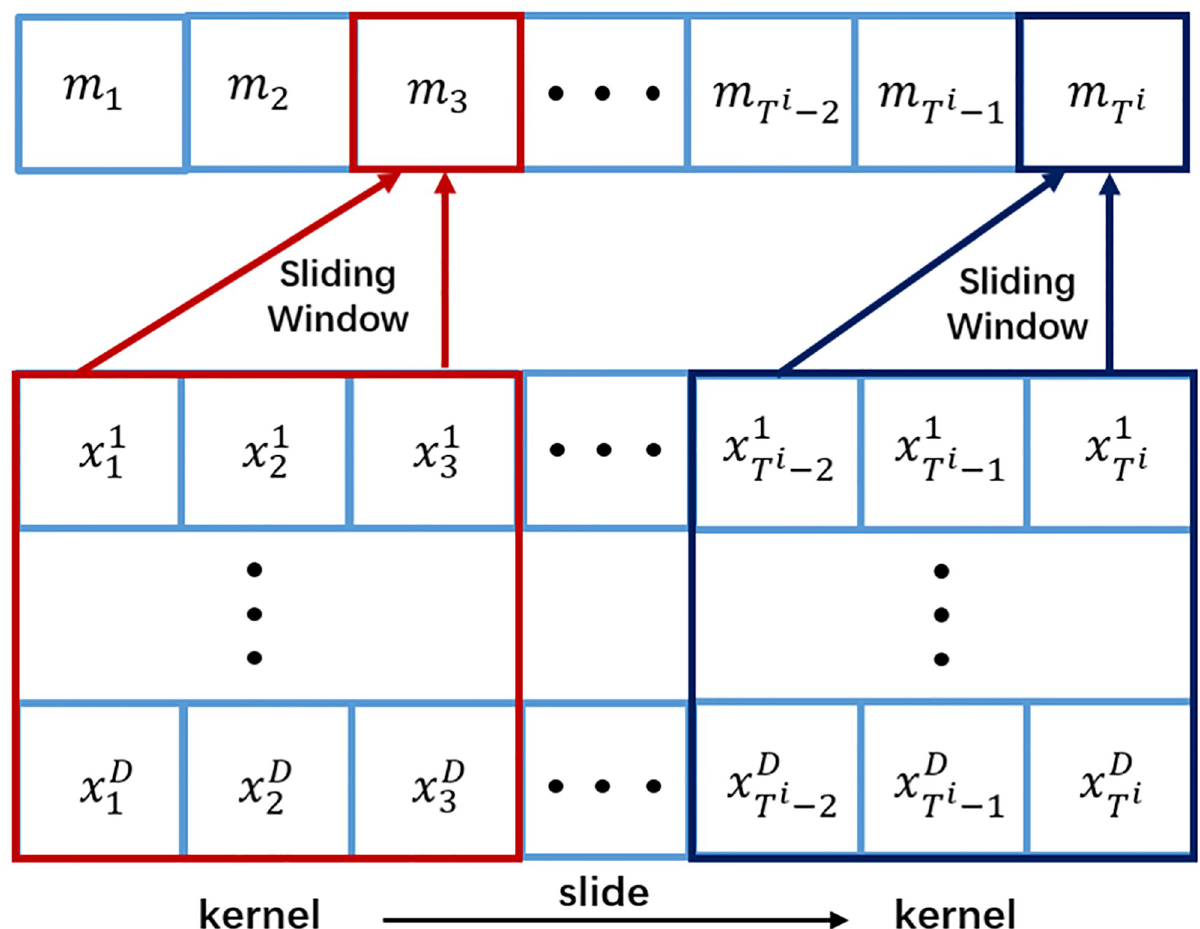
Fig 2. An example of the convolution operation of 1D-CNN. 1D-CNN moves the convolution kernel smoothly along the temporal wise of the input time series and generates the filtered signal by performing convergence over the local area of the input.